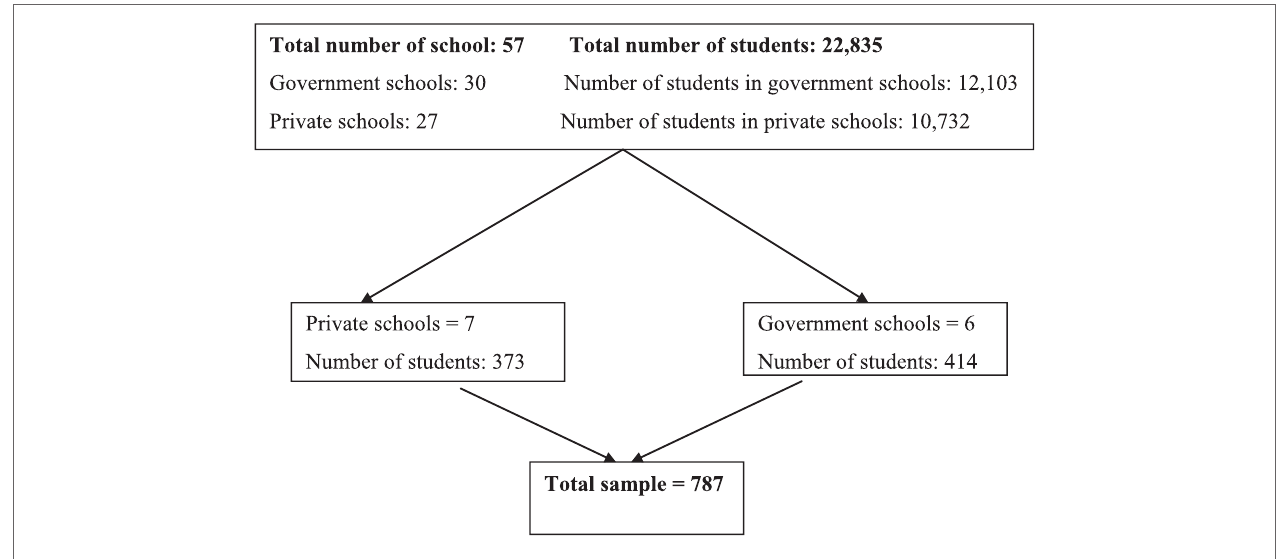
FigUre 1 | schematic representation of collected data